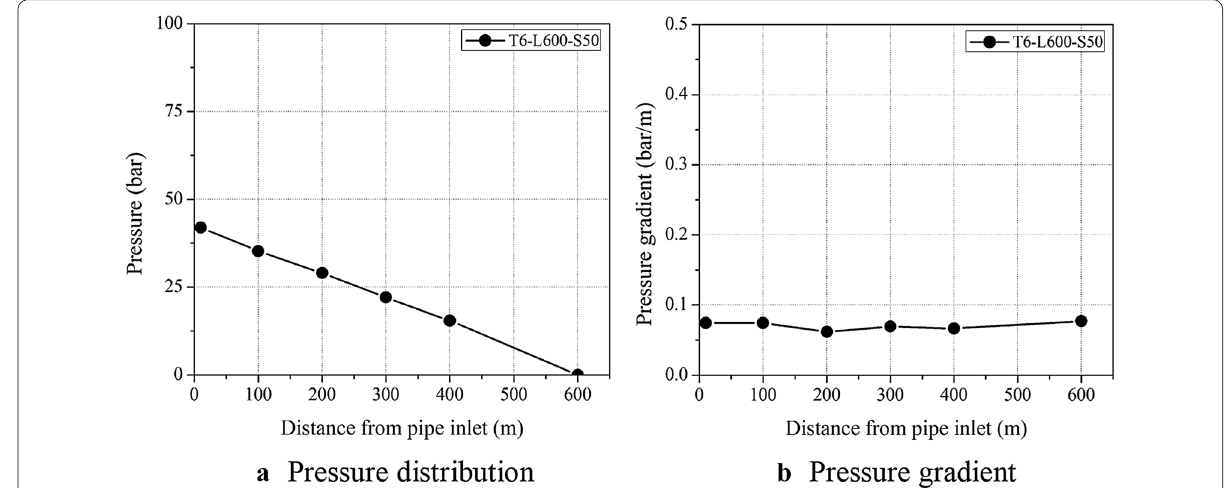
Fig. 7 Results of pressure and pressure gradient over the pipe length—constant